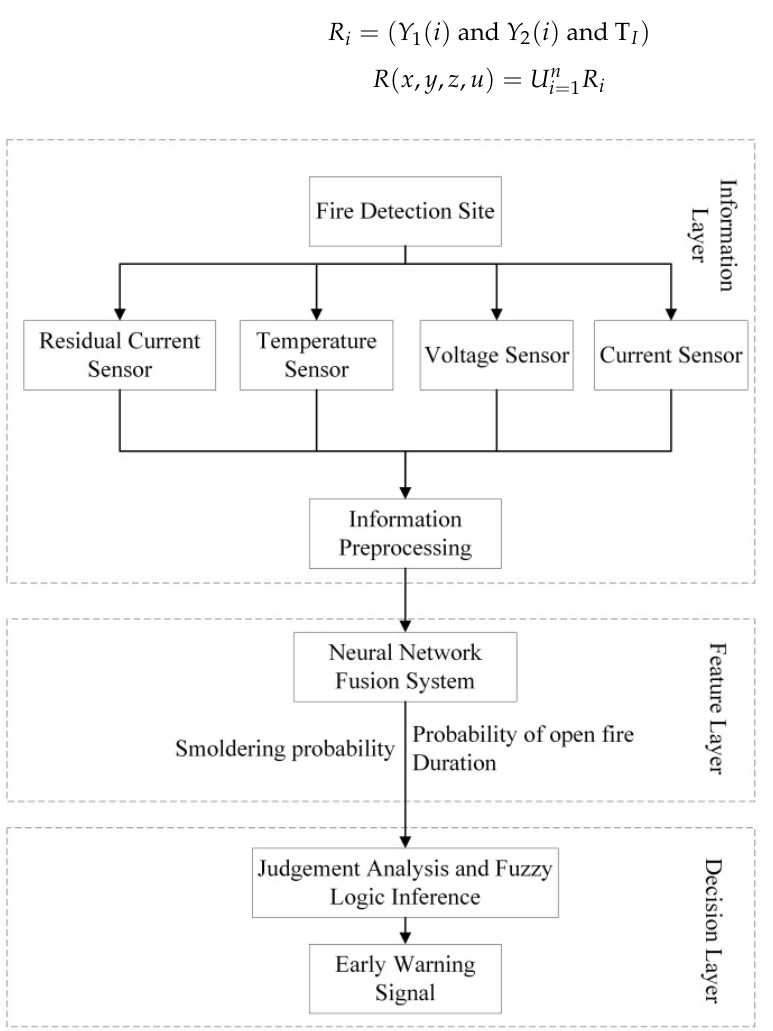
Figure 1. Multi-information fusion structure.